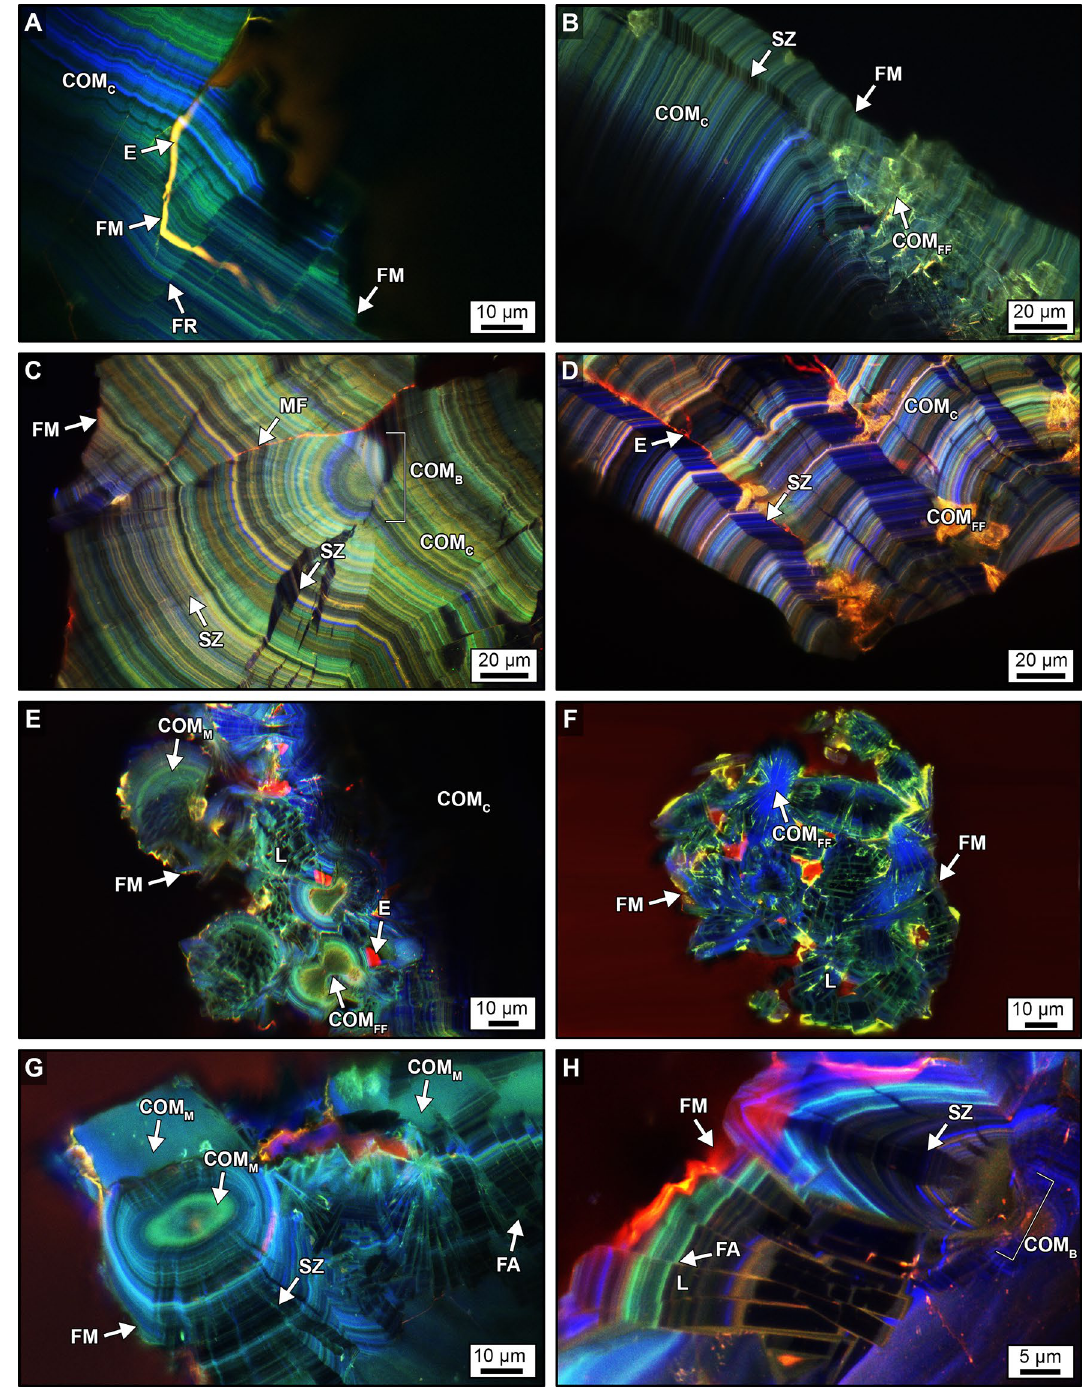
Figure 6. Crystalline architecture and fracture patterns of SWL-derived particles from groups 106F2-S1 and 106F4-S1 embedded in the epoxy plug. ( A – G ) CAF images. ( H ) SRAF image. Labels indicate: FR fracture, FM fracture margin, FA fault L lath, SZ sector zone, COM FF free-floating COM, COM C COM cortex, COM B bundles of COM radiating from a COM FF , MF microfractures, COM M , mimetic replacement COM; and E, red AF embedding epoxy. Image locations shown in Fig. 4 and corresponding T-PMT figure presented in Supplementary Fig.